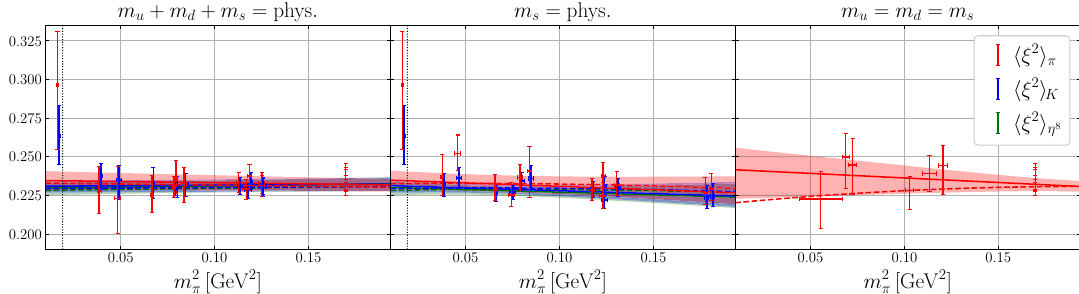
Figure 6 . Dependence of the moments on the squared pion mass, plotted in the continuum ξ 2 (cid:31) (cid:30) M limit. The points shown have been obtained by translating all data along the fitted function (keeping the masses fixed). The plots for the individual lattice spacings can be found in figure 12 in appendix A. The solid lines and shaded statistical error bands represent our main result. The dashed curves correspond to the mean value of an alternative fit (including a term of higher order in the masses) used to estimate the parametrization dependence as described in the main